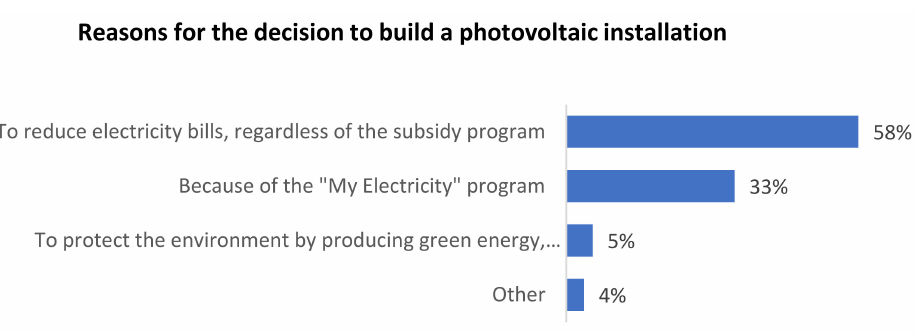
Figure 2. Main reason for PV installation ( n = 57). Source: own